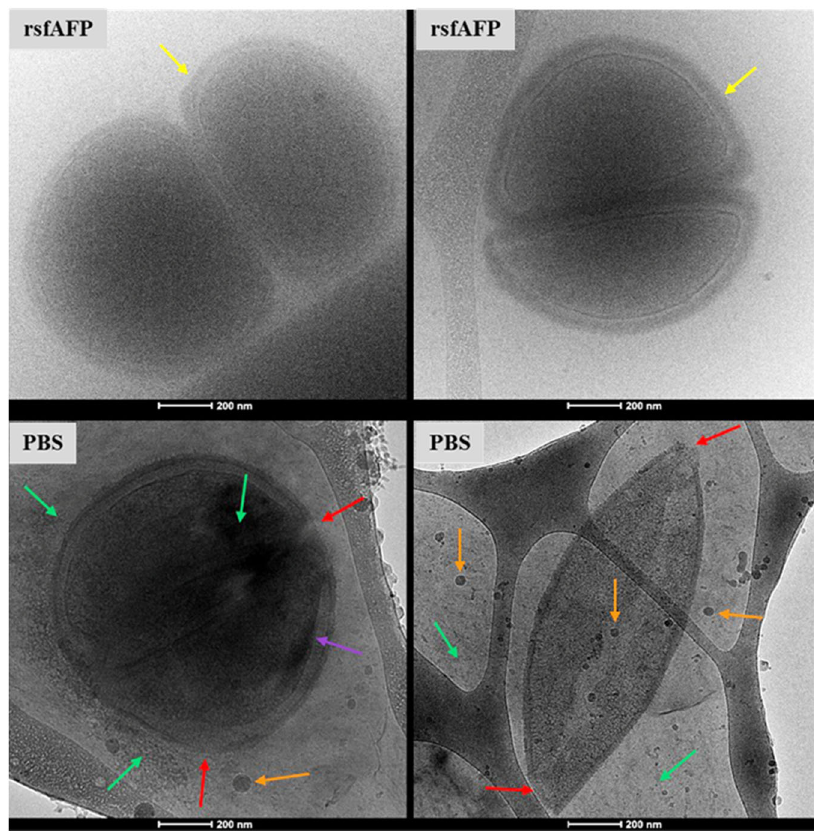
Fig. 7 The microscopic states of ice crystals and S. thermophilus cells were observed by Cryo-TEM. The blurred background represents the ice crystal (green arrow); the cell wall of S. thermophilus ruptured (red arrow); the cell membrane shrinkage (purple arrow); the rsfAFP wrapped around S. thermophilus (yellow arrows); vesicles formed by bacterial rupture (orange arrows). The concentration of rsfAPP used for the cryoprotective measurement was 0.1 mg/mL, and 20 mM PBS was used as a negative